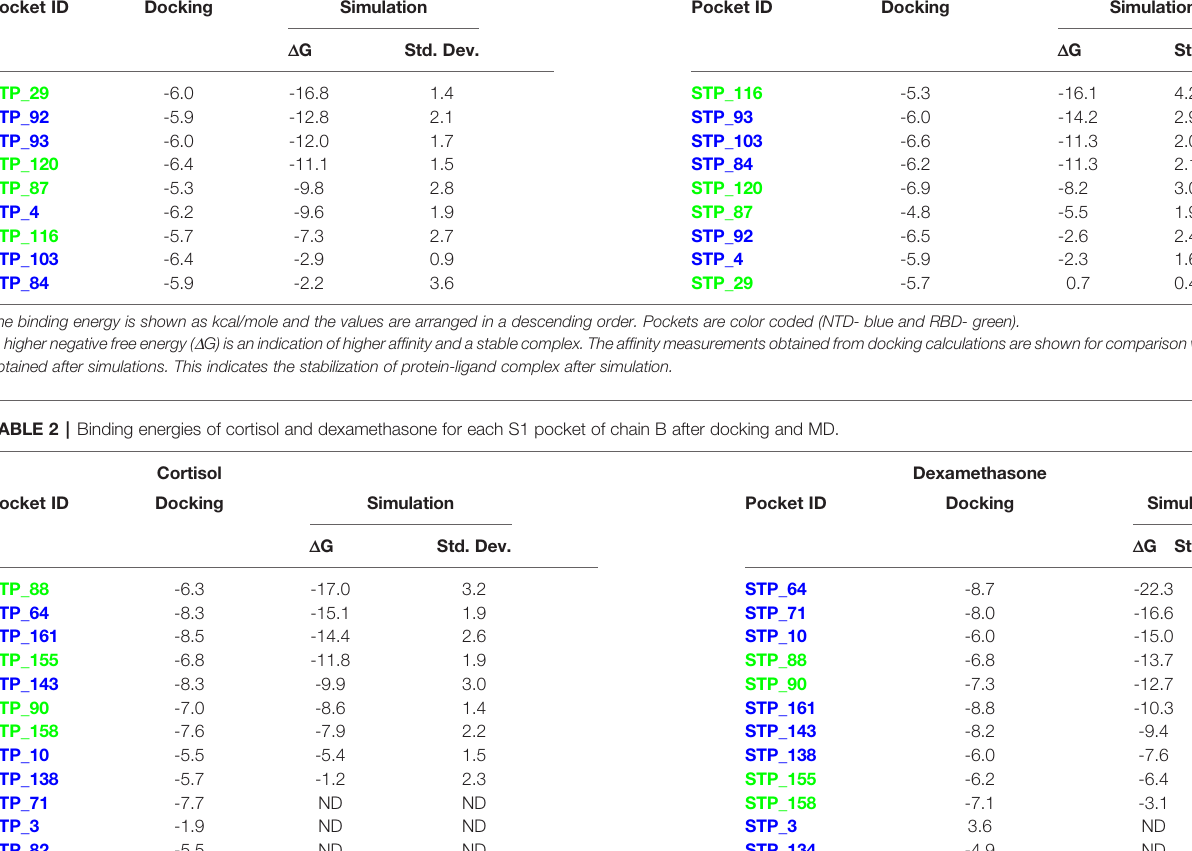
TABLE 1 | Binding energies of cortisol and dexamethasone for each S1 pocket of chain A after docking and MD. Cortisol Docking